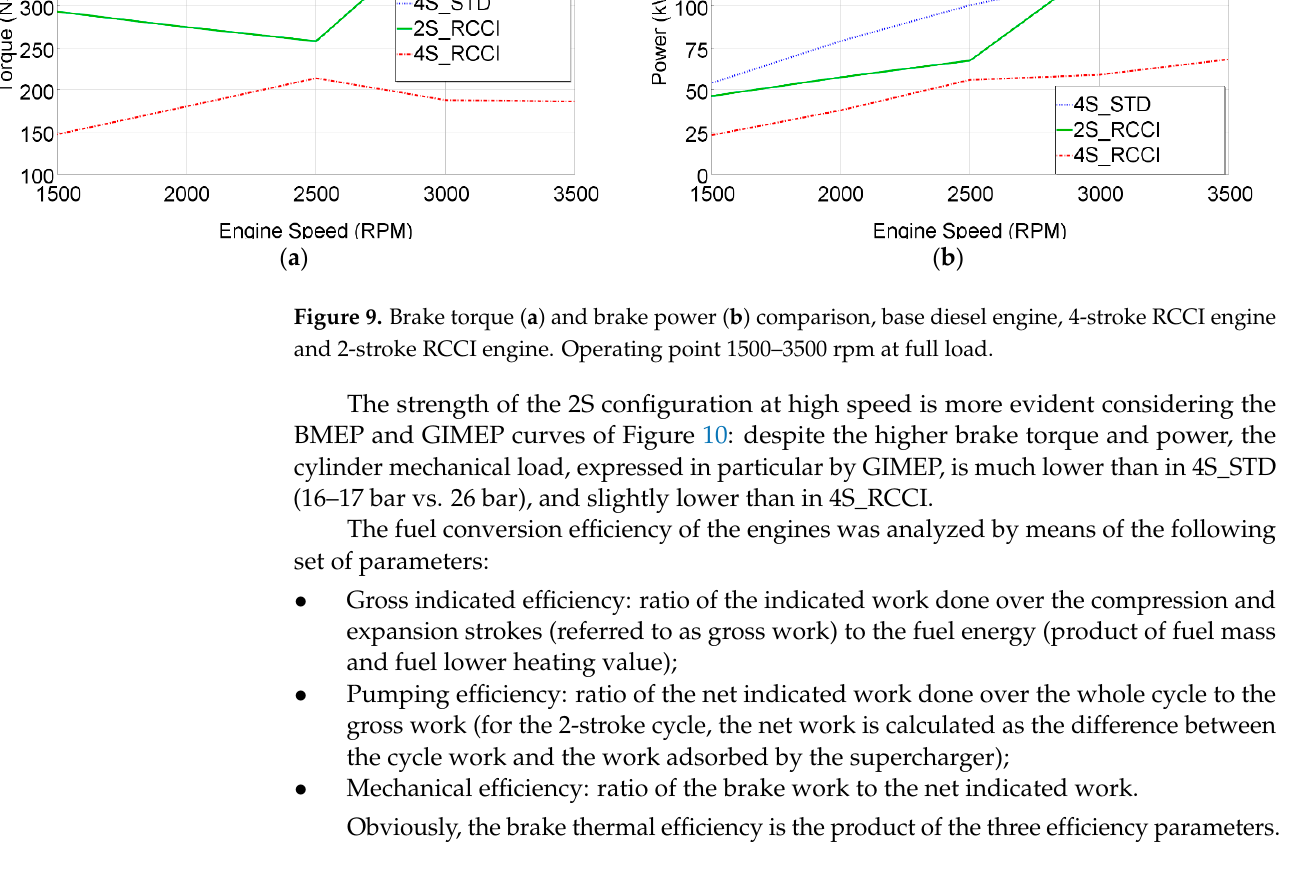
Figure 10. BMEP ( a ) and GIMEP ( b ) comparison between base diesel engine, 4-stroke RCCI engine and 2-stroke RCCI engine. Operating point 1500–3500 rpm at full load.